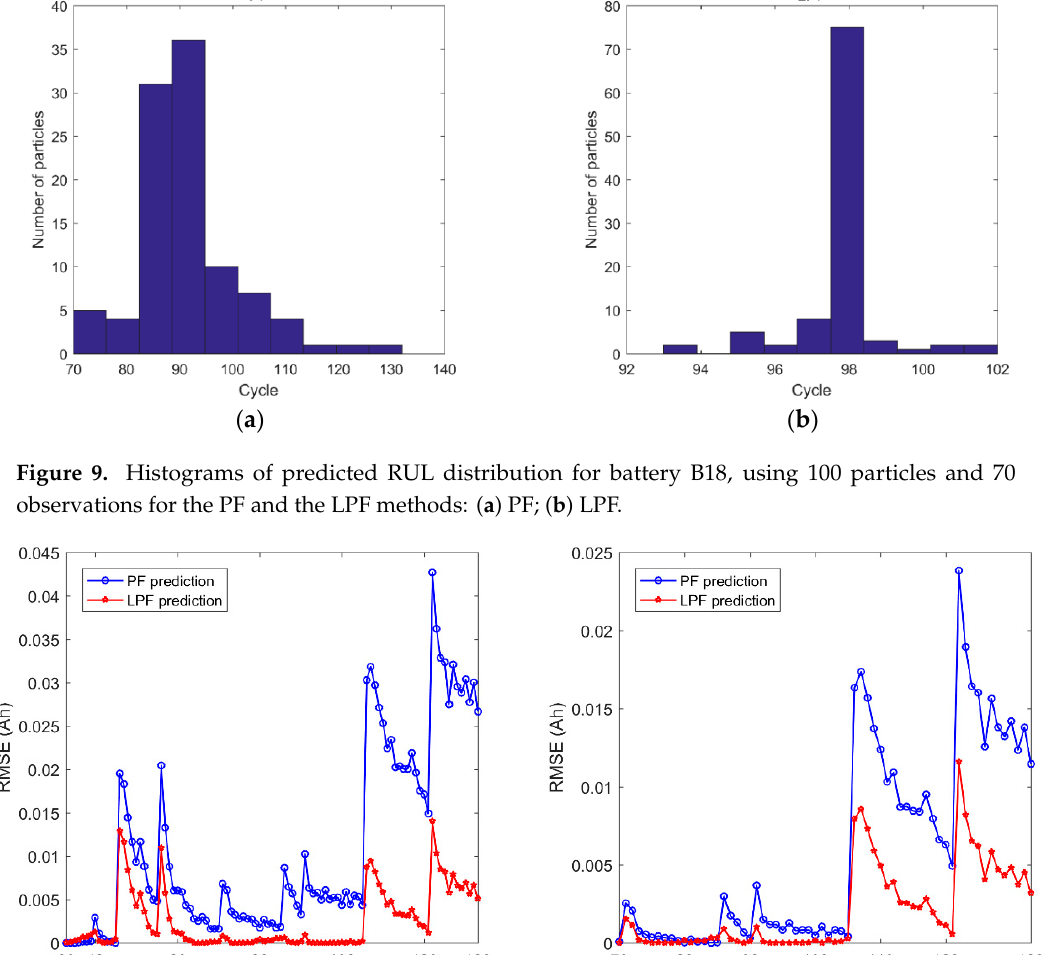
Energies 2019 , 12 , x FOR PEER REVIEW 13 of 17 Figure 9. Histograms of predicted RUL distribution for battery B18, using 100 particles and 70 observations for the PF and the LPF methods: ( a ) PF; ( b ) LPF.